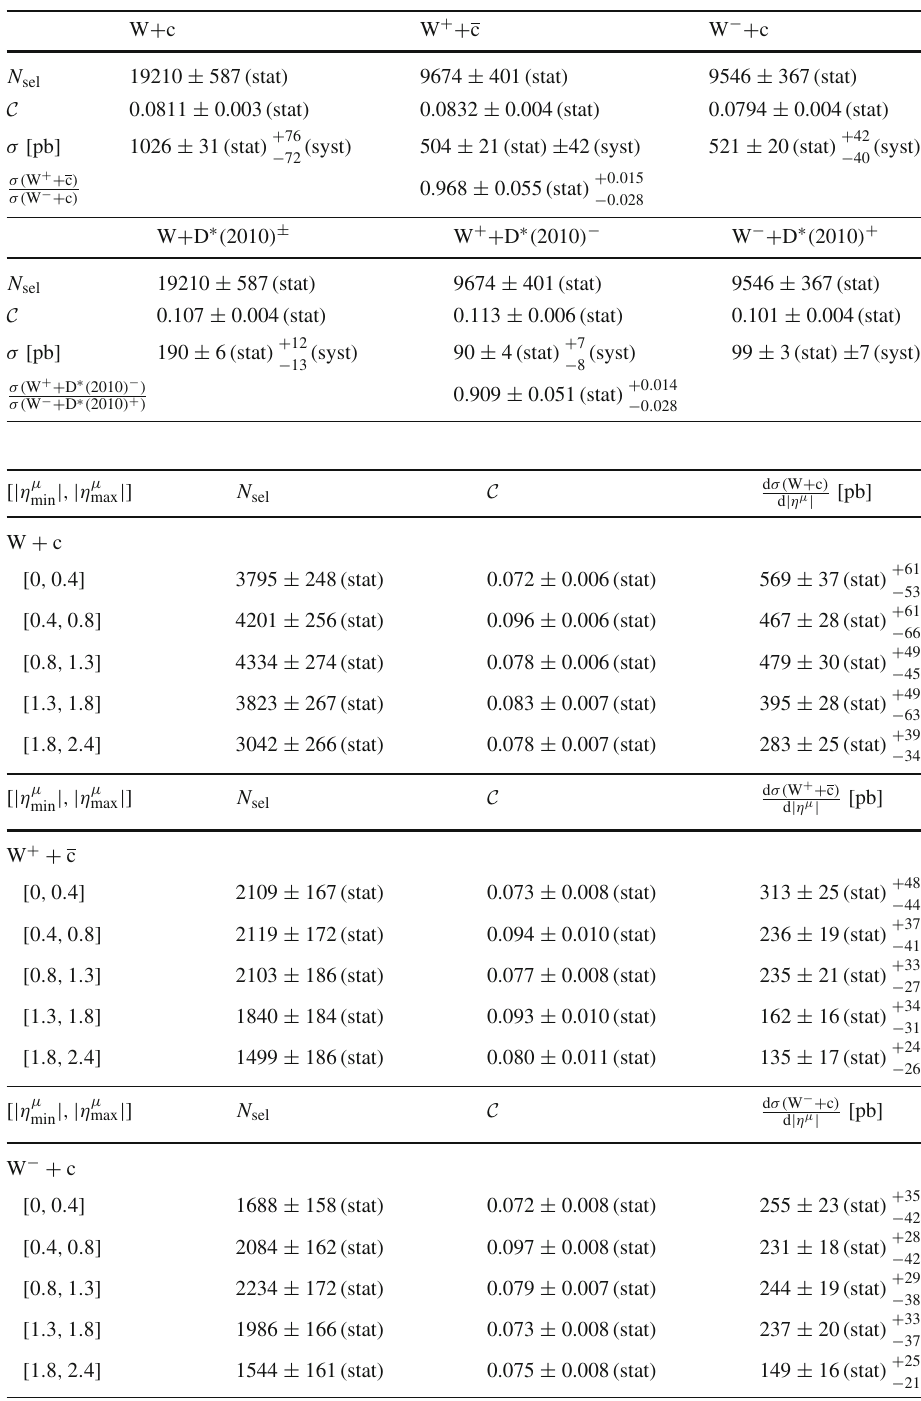
sections of W + c and W + D ∗ ( 2010 ) ± production in the fiducial range of the analysis. The correction factor C accounts for the acceptance and efficiency of the detector